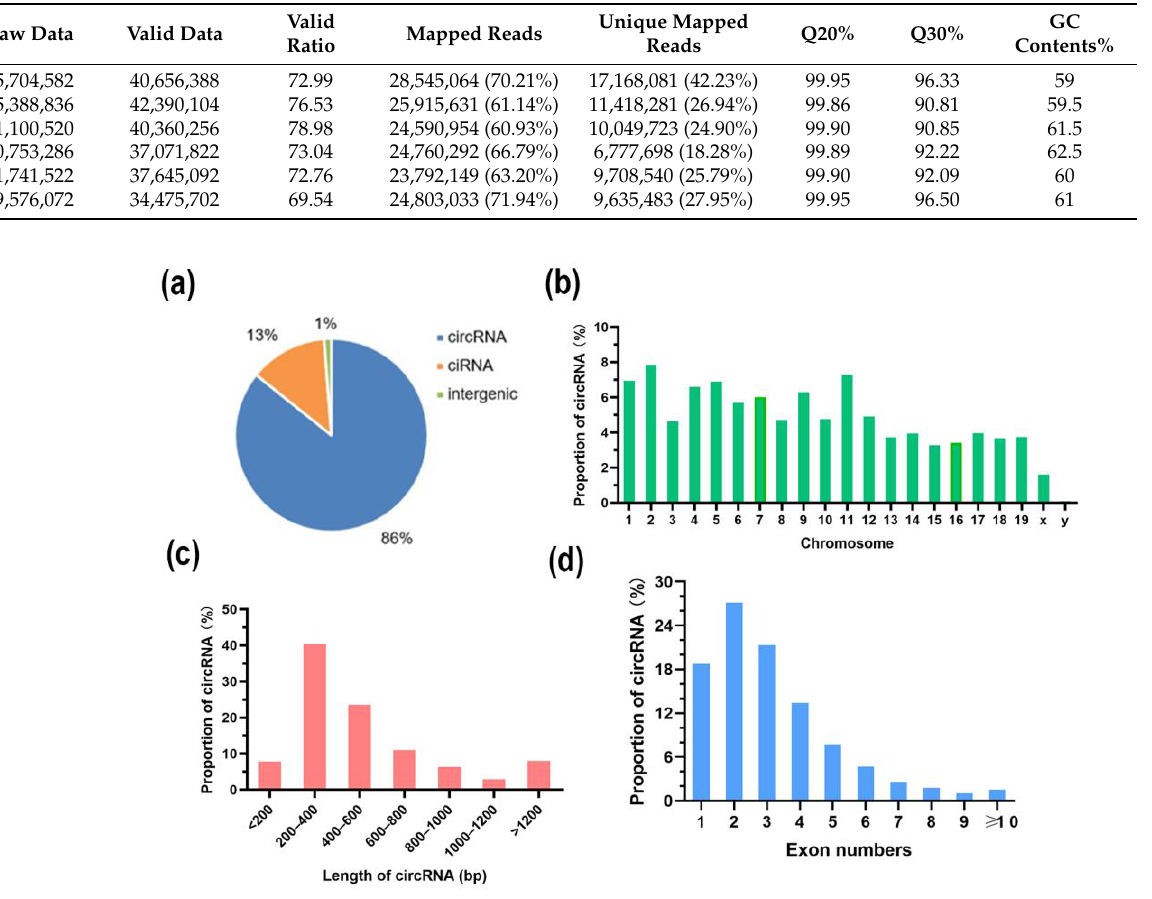
Figure 2. Overview of RNA-seq. ( a ) The types of total identified circRNA; ( b ) the distribution of total identified circRNA on the chromosome; ( c ) the length of circRNA; ( d ) exon numbers of circRNA.